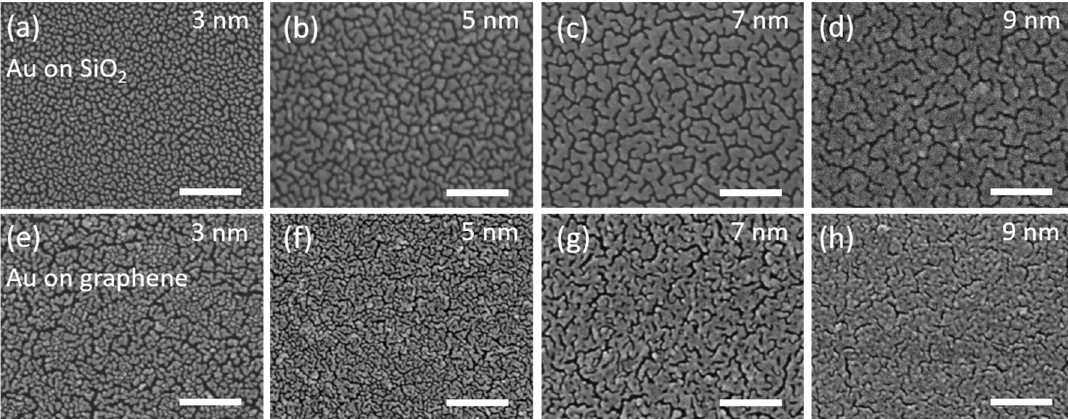
Figure 2. SEM images of the morphology the gold films deposited on the SiO 2 /Si substrate with thicknesses ( a ) 3 nm ( b ) 5 nm ( c ) 7 nm ( d ) 9 nm and on the graphene/SiO 2 /Si substrate with thicknesses thicknesses ( a ) 3 nm ( b ) 5 nm ( c ) 7 nm ( d ) 9 nm and on the graphene / SiO 2 / Si substrate with thicknesses ( e ) 3 nm ( f ) 5 nm ( g ) 7 nm ( h ) 9 nm. The scale bar is 200 nm. ( e ) 3 nm ( f ) 5 nm ( g ) 7 nm ( h ) 9 nm. The scale bar is 200